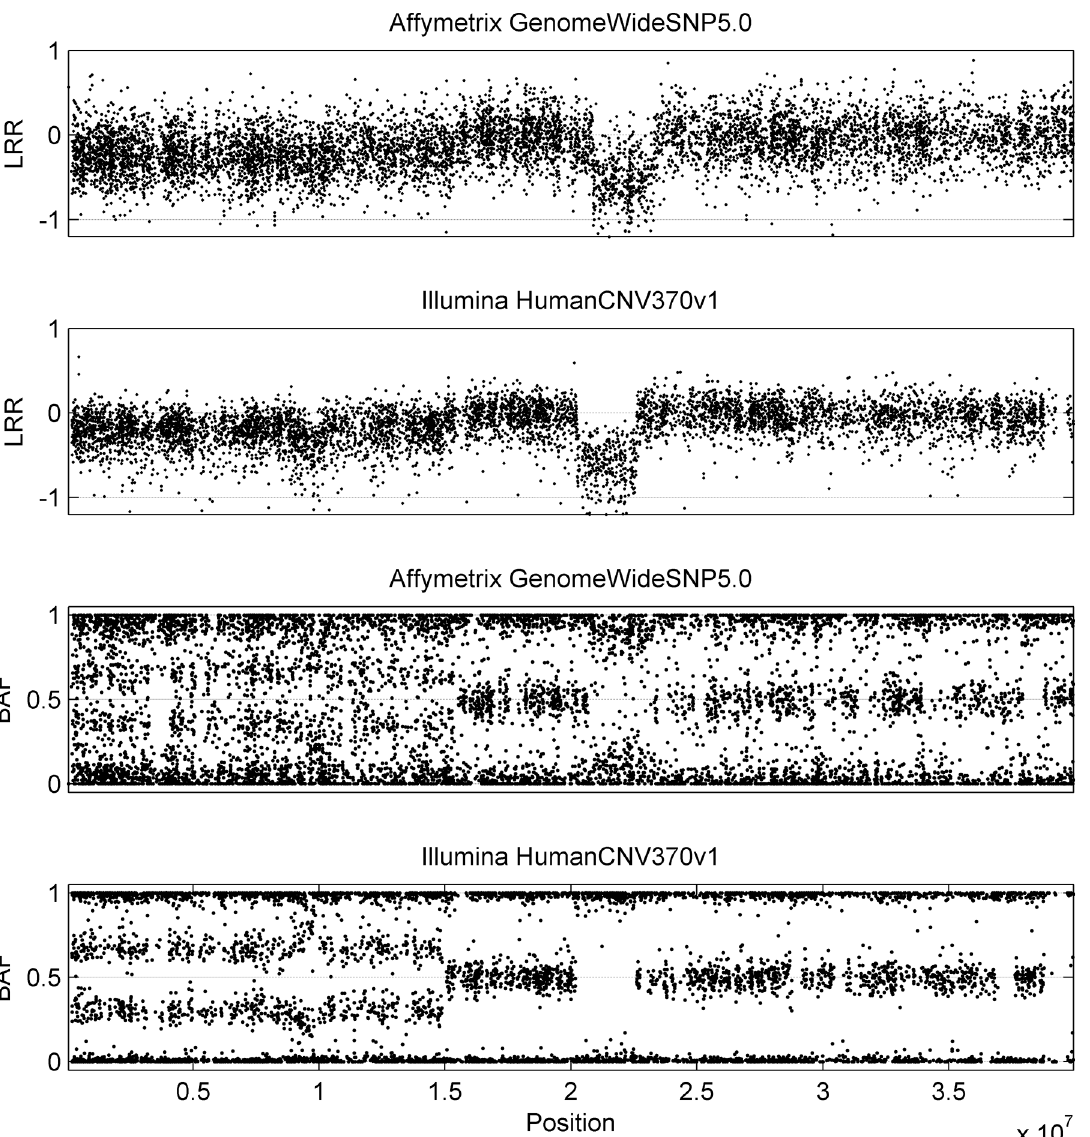
Fig 1. Comparison of genotyping signals between Affymetrix and Illumina platform. The Log R Ratio (LRR) and B Allele Frequency (BAF) signals are illustrated for breast tumor sample H1395, which is analyzed by both Affymetrix GenomeWide 5.0 and Illumina HumanCNV370v1 platform.